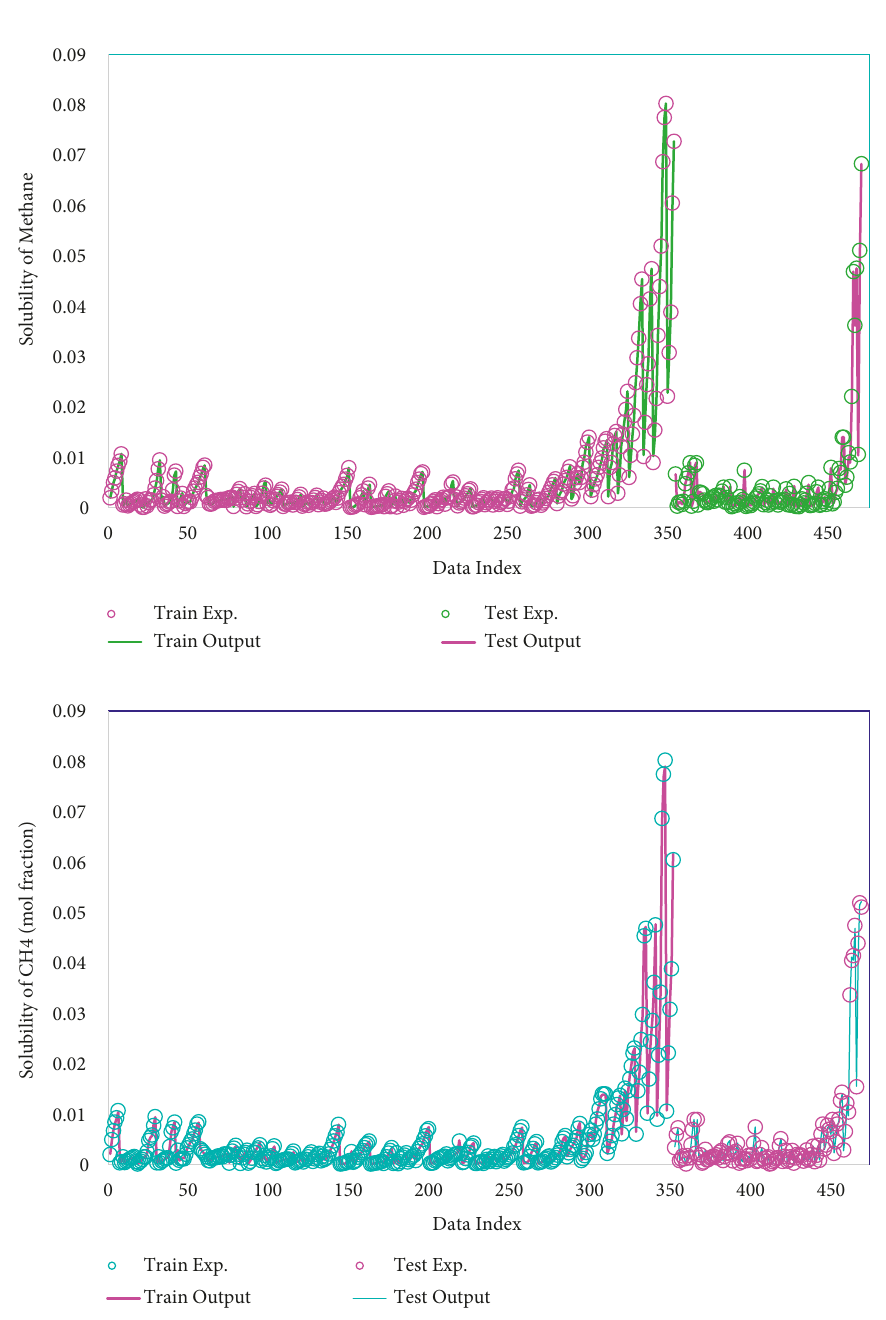
Figure 4: Simultaneous comparison of predicted and experimental methane solubility values for (a) ANFIS (b)